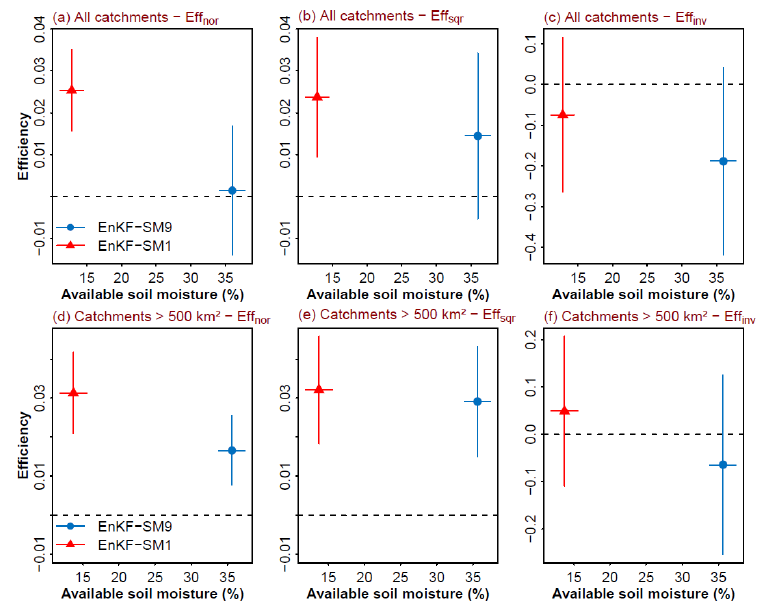
Figure 9. Comparison between average efficiency index of streamflow simulation using assimilation of EnKF-SM9 model and assimilation of EnKF-SM1 model and OL-based model for all catchments ( a – c ) and catchments > 500 km² ( d – f ). Points above zero-dash line indicate an improvement in streamflow simulation after implementing the data assimilation framework as compared with the OL-based model simulation.